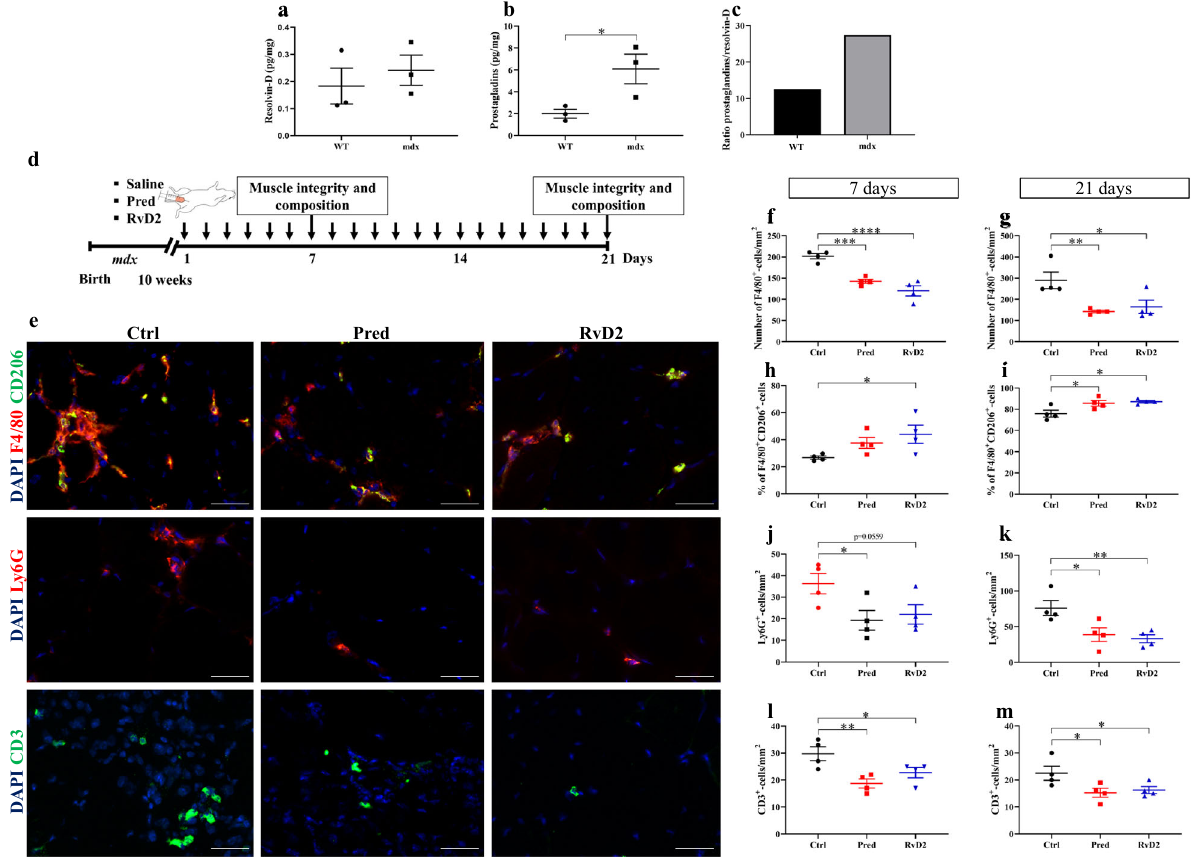
Fig. 4 Resolvin-D2 regulates in fl ammation in dystrophic mdx mice. a , b Quanti fi cation by mass spectrometry (LC-MS/MS) of Resolvin-D isoforms (RvD1, RvD2, RvD3, 17(R, S)-RvD4, RvD5), and ptgs1/2-derived prostaglandins (PGE 2 , PGF 2 α ) in the gastrocnemius muscle of wildtype (WT) and mdx mice ( b ) p = 0.0444. c Ratio of prostaglandins/Resolvin-D in the gastrocnemius muscle of wildtype and mdx mice. d Timeline of daily intraperitoneal ( ip ) injection of Resolvin-D2 (RvD2, 5 μ g/kg/day), prednisone (pred, 2 mg/kg/day), or vehicle (ctrl) in mdx mice. e Immuno fl uorescence on tibialis anterior (TA) muscle sections of mdx mice for F4/80 (total macrophage marker; red) and CD206 (anti-in fl ammatory macrophage marker; green), Ly6G (neutrophil marker; red), and CD3 (lymphocyte marker; green), and DAPI (blue). Scale bars = 50 μ m. f , g Quanti fi cation of total macrophages in TA muscles following 7 days f (Ctrl vs. Pred, p = 0.0007; Ctrl vs. RvD2, p < 0.0001; Pred vs. RvD2 = 0.0835), and 21 days g (Ctrl vs. Pred, p = 0.0060; Ctrl vs. RvD2, p = 0.0141; Pred vs. RvD2, p = 0.6009). h , i Percentage of anti-in fl ammatory macrophages (F4/80 + CD206 + ) in TA muscles sections at h 7 days (Ctrl vs.